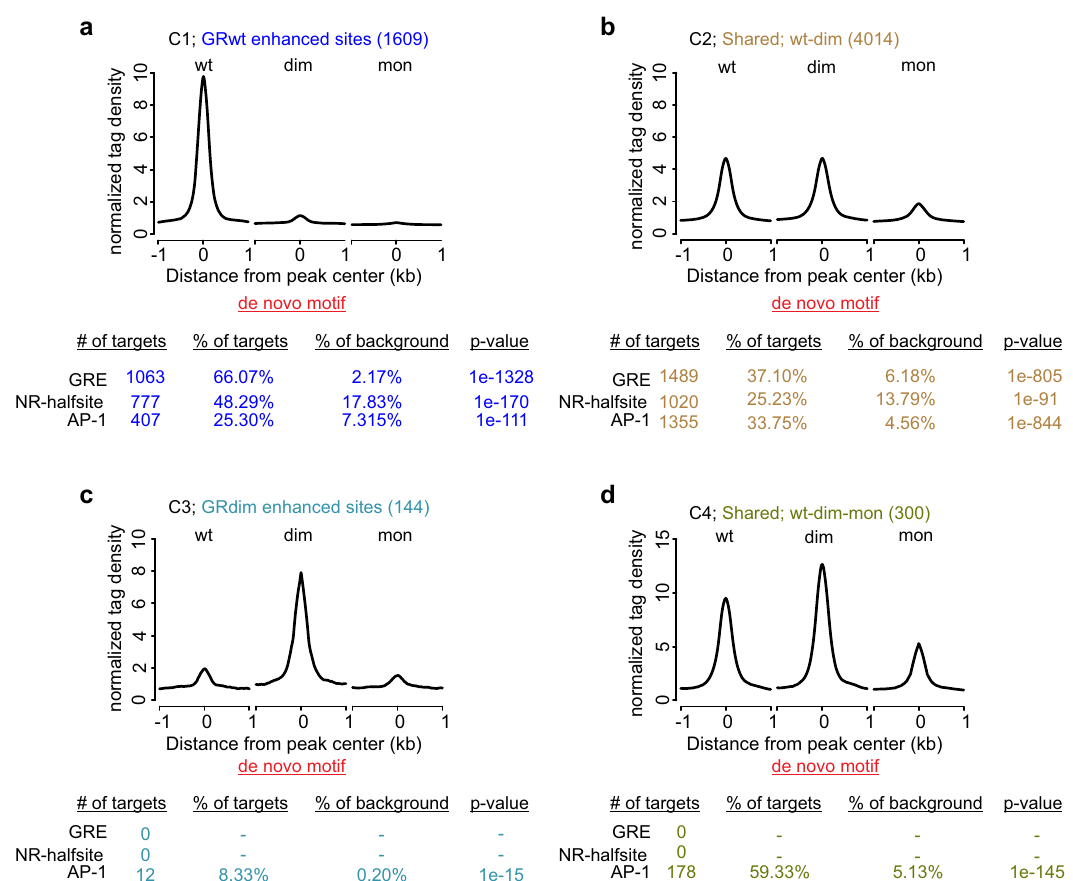
Fig. 3 Chromatin binding and de novo motif analyses of GRwt, GRdim, and GRmon. a – d Aggregate plots of + Dex GR binding ( α -GFP) of each receptor type for each cluster. All aggregate plots normalized to 10 million reads, and further to local tag density (tags per site per bp). De novo motif analysis shows the percentage of sites with a motif and the calculated background percentage from 50 K random sites (with matched GC% content). p-value of the motif enrichment is shown. Source data are provided as a Source Data fi